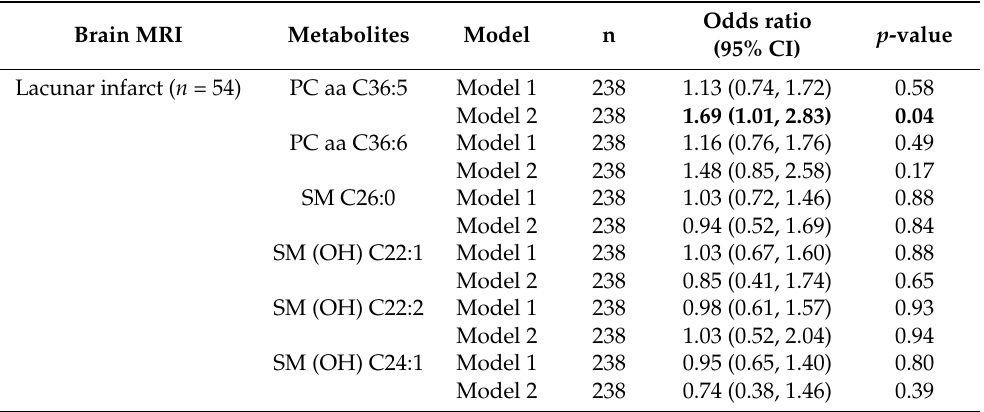
Table 2. Weighted* cross-sectional associations of plasma metabolites with lacunar infarcts, Atherosclerosis Risk in Communities (ARIC) Study, 2011 to 2013. Odds ratios and 95% confidence intervals (CI) per 1-standard deviation difference in the log-transformed phospholipid.